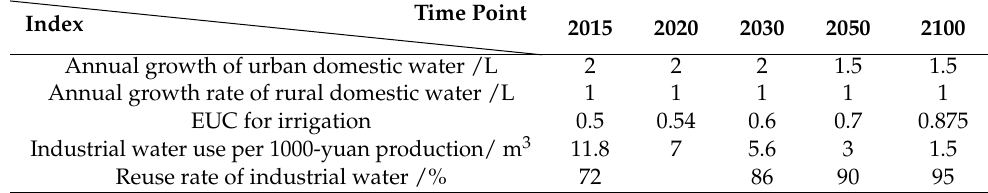
Figure 13. Social-economic factors forecasting in Shigu section: population ( a ), livestock ( b ), irrigated area ( c ), and industrial production ( d ). Table 5. Social-economic control years and